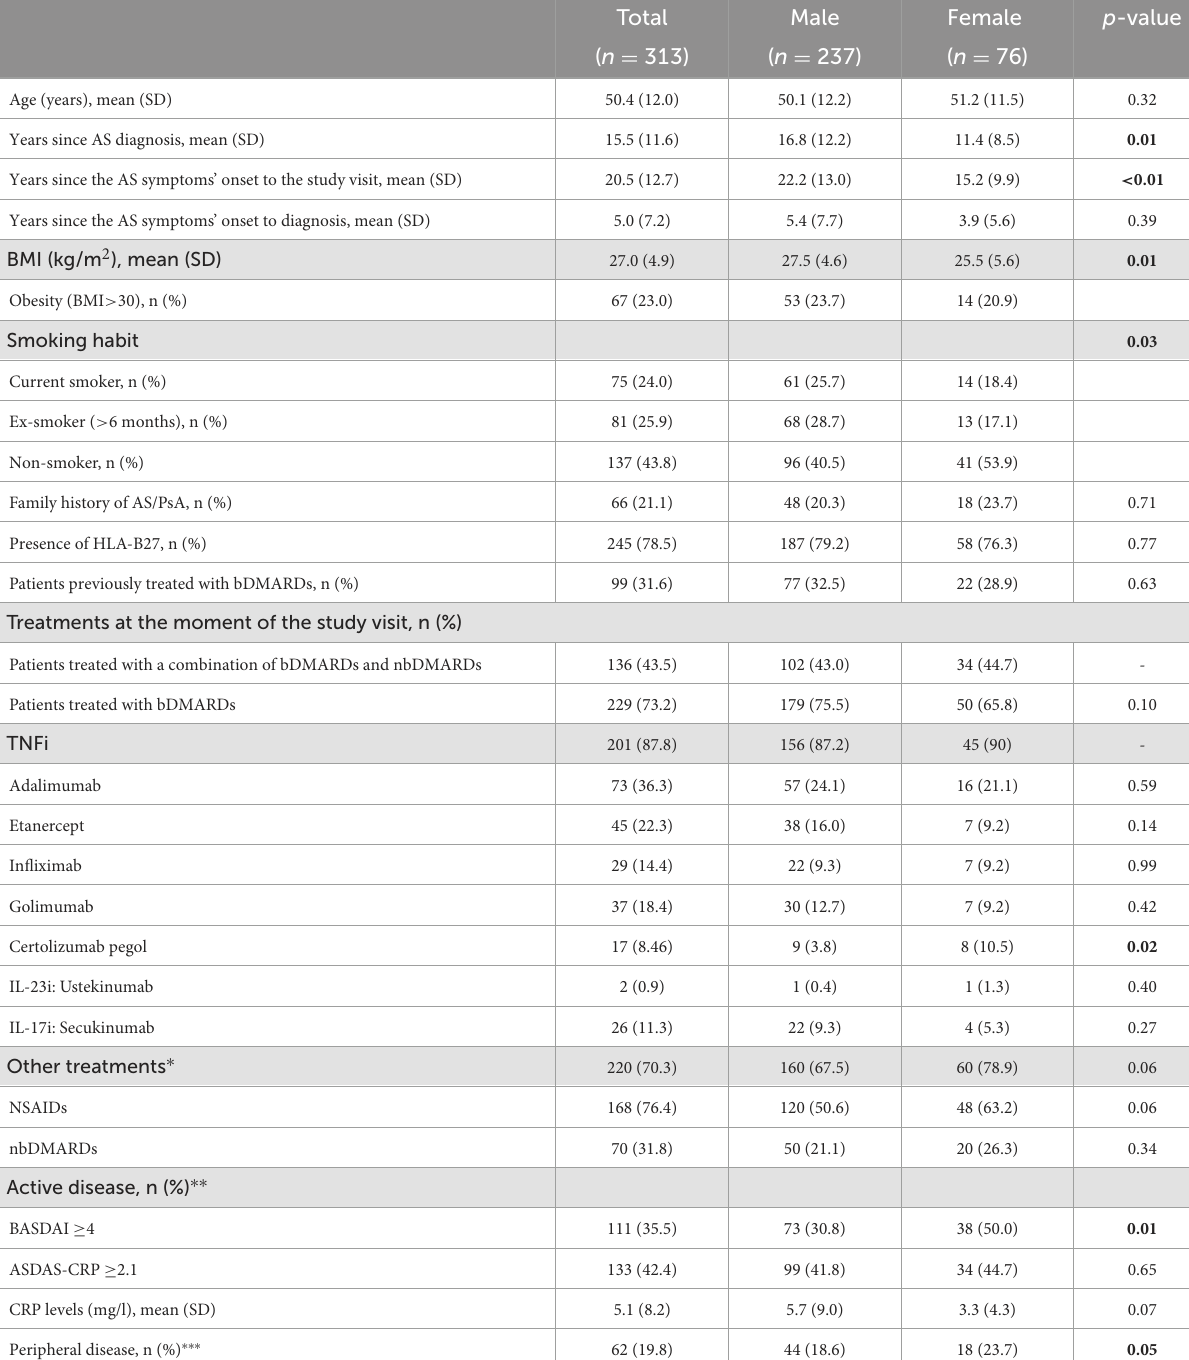
TABLE 1 Baseline demographic and clinical characteristics of the patients with AS analyzed in the MIDAS study. Total Male Female p -value ( n = 313) ( n = 237) ( n =